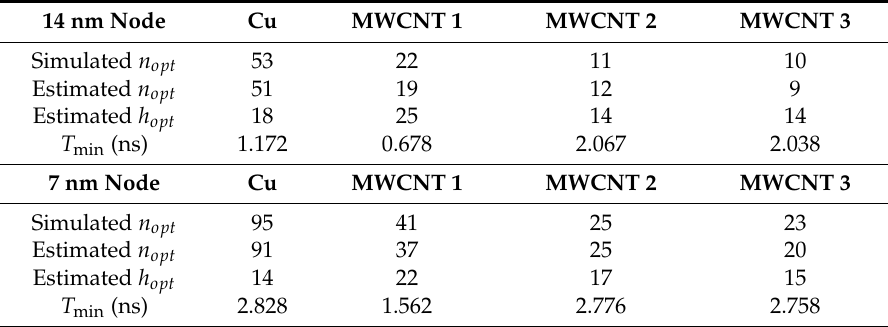
Figure 8. Optimal number of repeaters (Inset: minimum propagation delay) versus length for global ‐ level Cu and MWCNT interconnects at the 14 nm technology node.